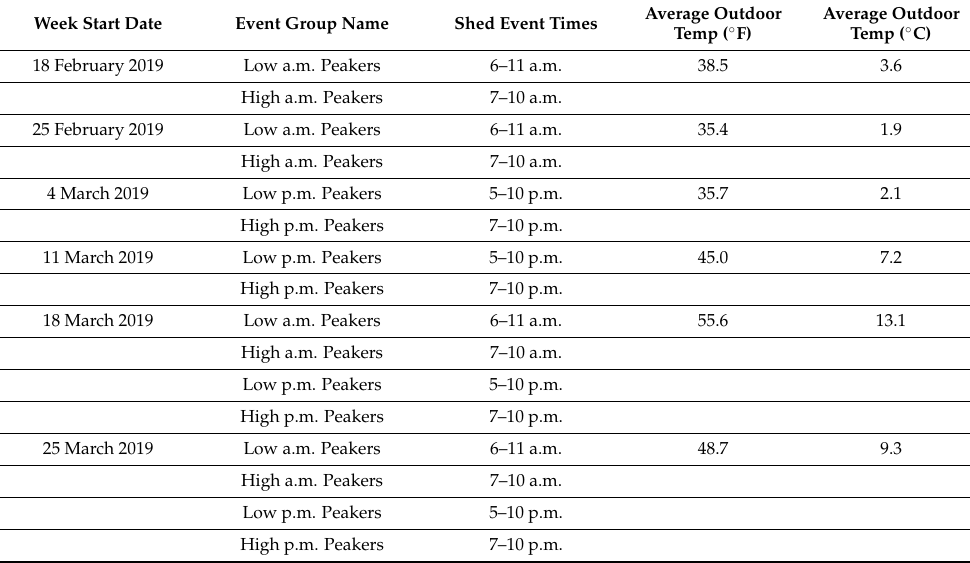
Table 3. More Aggressive, Targeted Strategy Schedule.